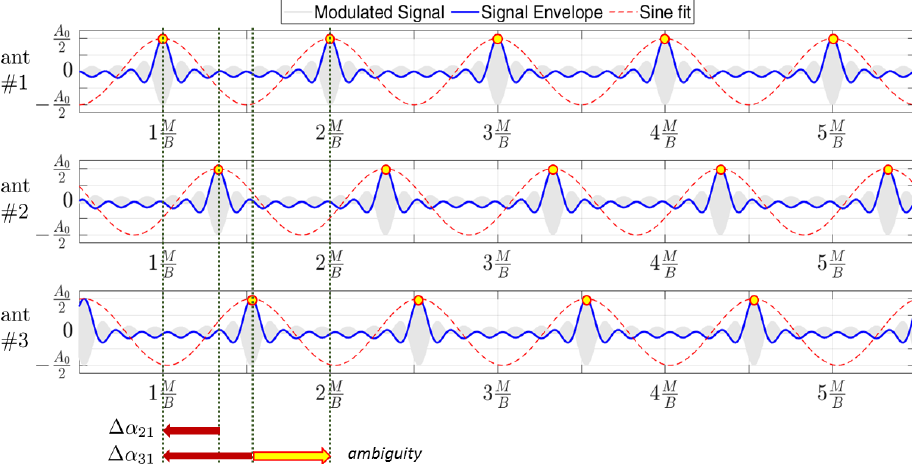
Figure 3. Example of a set of impinging multi-tone signals on an